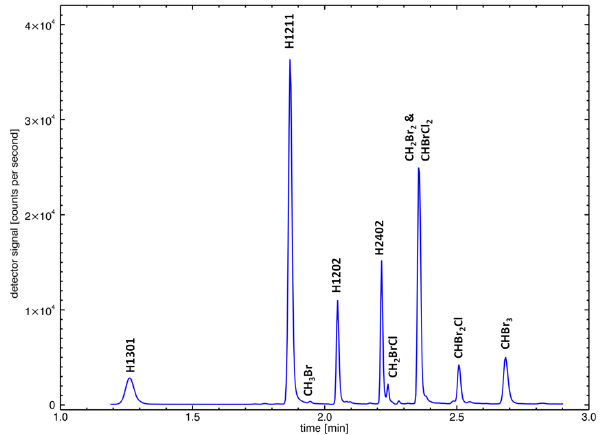
Figure 2. NICI chromatogram ( m/z 79) from GHOST-MS instru-